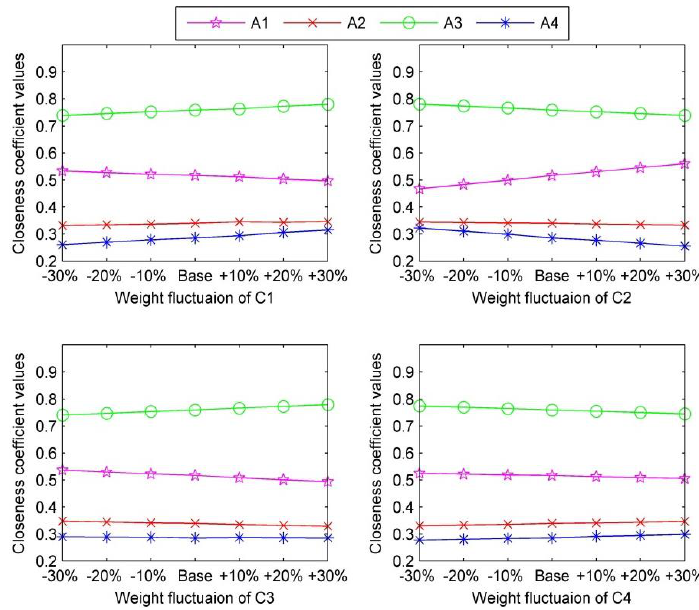
Figure 5. Sensitivity analysis result of changing the four criteria weight.